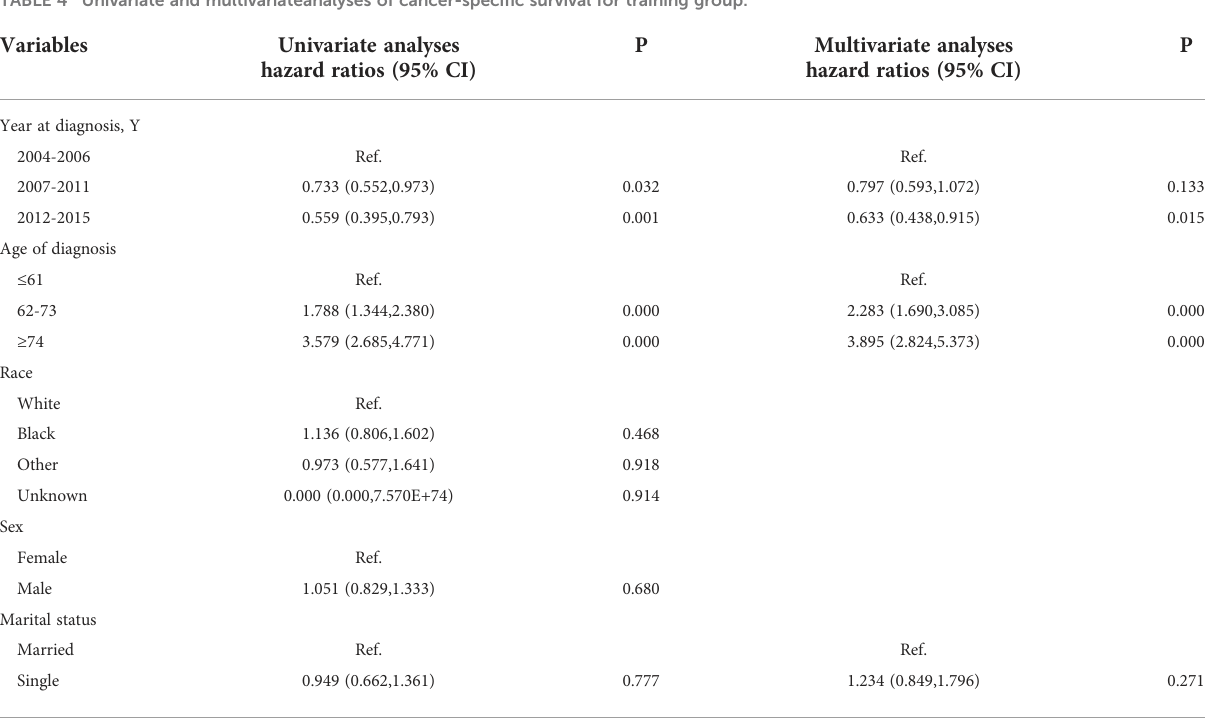
TABLE 4 Univariate and multivariateanalyses of cancer-speci fi c survival for training group.